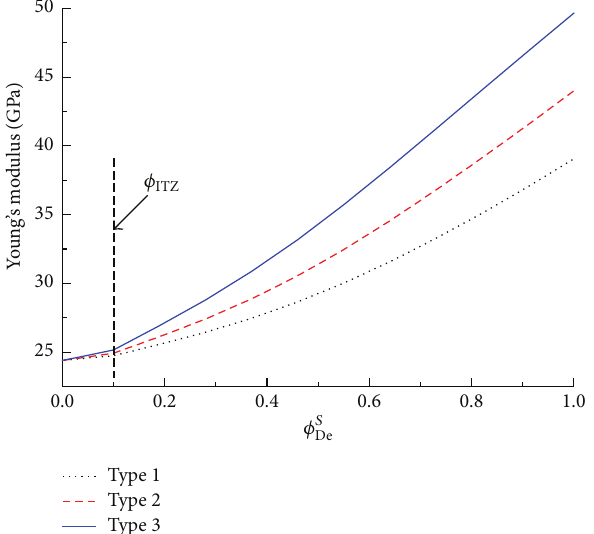
Figure 13: Influence of the properties of the deposition products on the Young modulus of repaired concrete during the healing process, where 𝜙 ITZ is the volume fraction of ITZ in the equivalent particle; 𝜙 𝑆 De is the volume fraction of the deposition products in the equivalent particle.